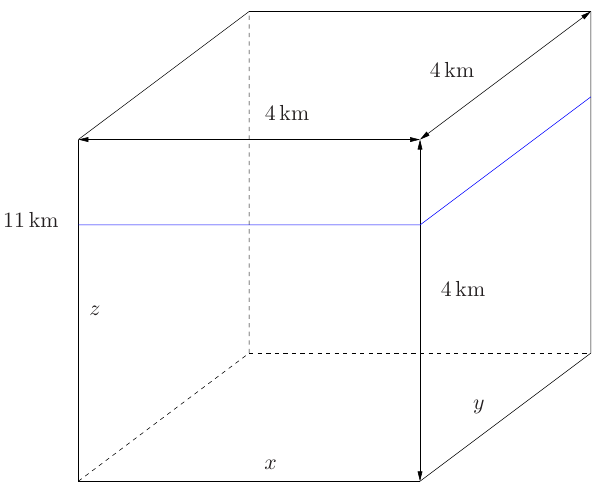
Figure 1. Sketch of the computational